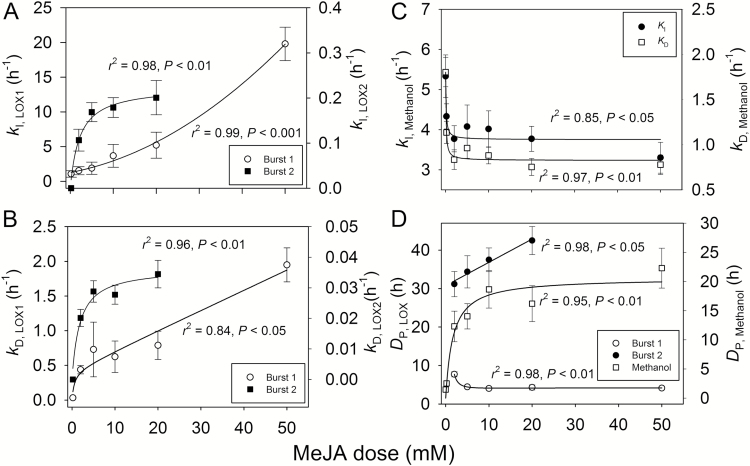
First-order rate constants (kI) for the initial increases (Equation 2, kI; A, C) and decreases (Equation 3, kD; B, C) of the MeJA-induced emissions for the first (kI,LOX1 and kD,LOX1) and the second (kI,LOX2 and kD,LOX2) emission burst of LOX volatiles (A, B) and methanol (C), and the duration (DP) of the first and second LOX compound emission burst and methanol emission burst (D) as dependent on the MeJA concentration in C. sativus leaves (see Fig. 2 for sample responses). Experimental treatments are as in Fig. 1 and data coverage is as in Fig. 3. The regressions describing the statistical effects of MeJA on the rate constants were the following: y=0.0050x2+0.12x+1.27 for kI,LOX1 and y=0.214x/(1.87+x) for kI,LOX2 in (A), y=2.51(1–e−0.028x) for kD,LOX1 and y=0.0357x/(1.42+x) for kD,LOX2 in (B), y=3.75 + 0.194/(0.123+x) for kI,methanol and y=0.826 + 0.0920/(0.094+x) for kD,methanol in (C), y=4.24–3.11/x+20.1/x2 for DP,LOX1, y=30.8 + 0.604x for DP,LOX2, and y=20.6x/(1.65+x) for DP,methanol in (D). Three replicate treatments at each MeJA application concentration were carried out.